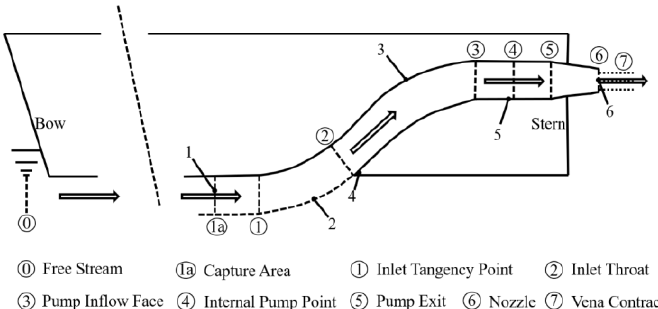
Figure 1. Definition of the momentum flux method reference stations.